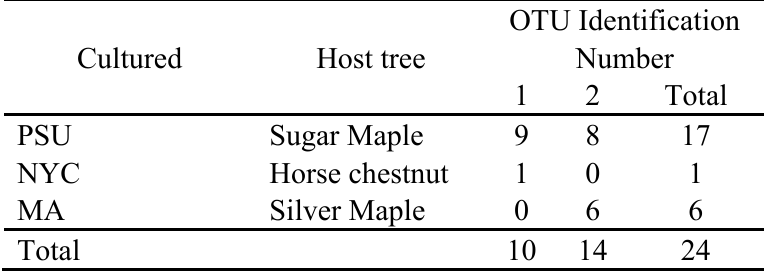
Table 3. Placement of cultured strains into Operational Taxonomic Units using TEF1- α locus. All PSU-, NYC-, and MA-derived cultured isolates were classified into the same two OTUs that were detected in the culture-independent